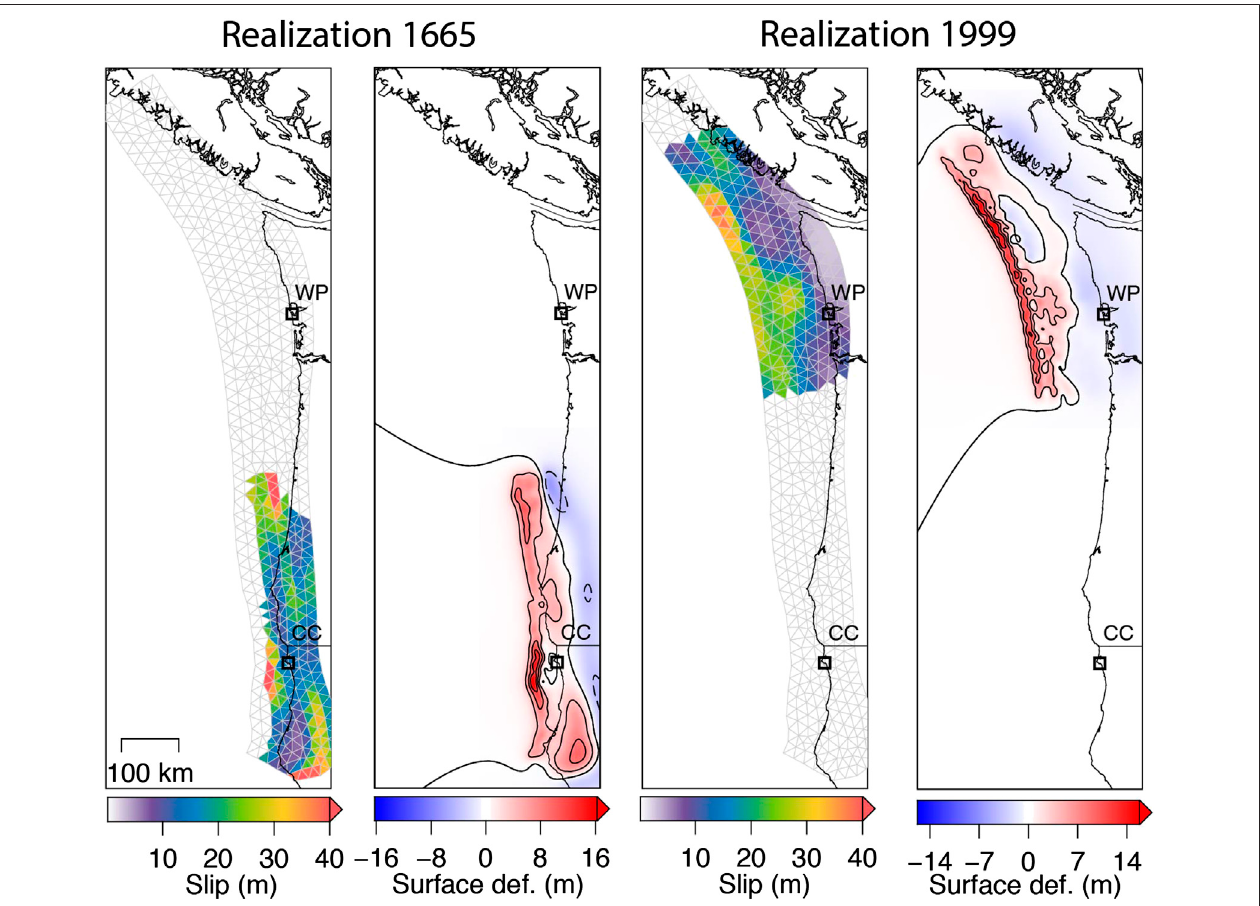
FIGURE 2 | Slip on our fault geometry and associated sea fl oor deformation for two sample realizations, numbered 1,665 and 1,999, shown in Figures 5 , 8 . WP marks the location of Westport, WA. CC marks the location of Crescent City, CA.